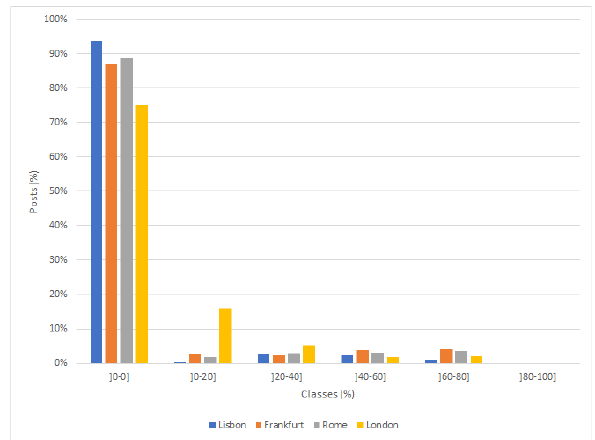
Figure 7. Percentage of posts that are positioned within a given